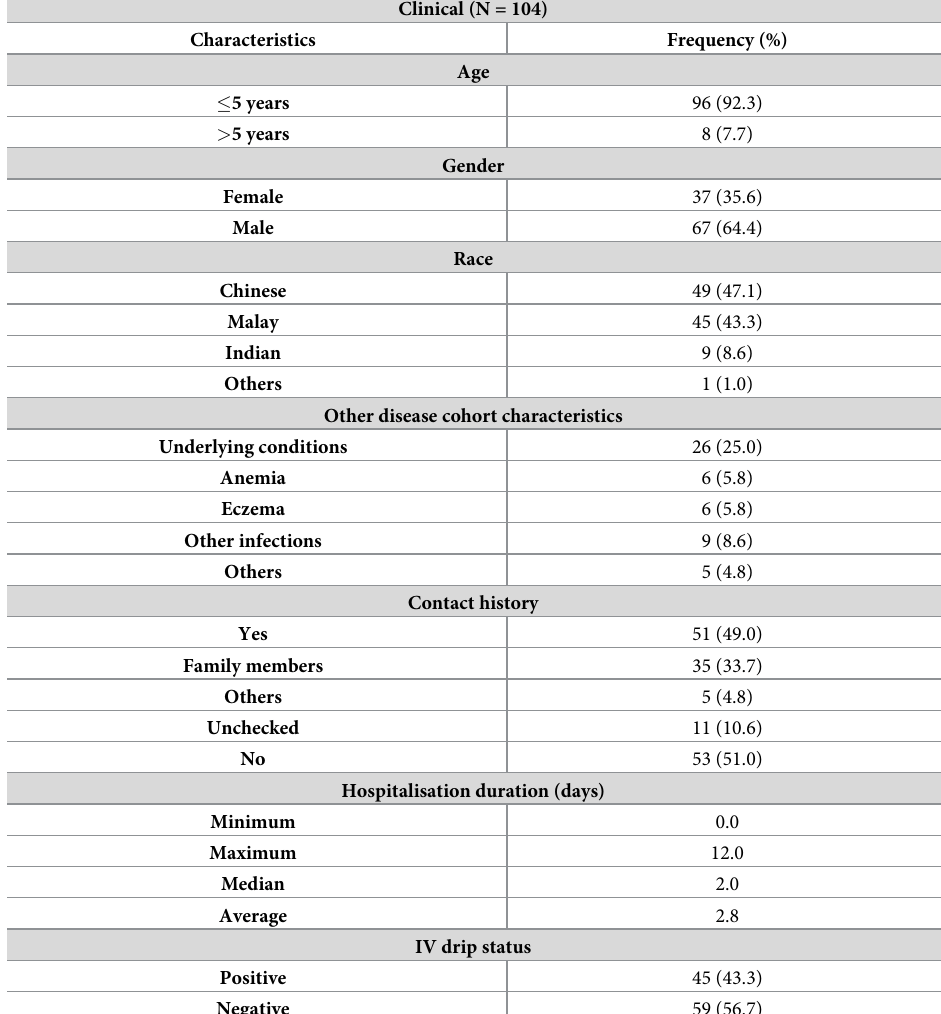
Table 1. Sociodemographic distribution of pediatric patients recruited into this study. Characteristics collected from pediatric patients admitted for HFMD into KK Women’s & Children’s Hospital includes their age, gender, race, hospitalization duration, contact history, IV drip status and other